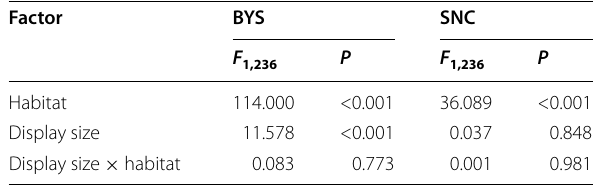
Table 2 Results of the linear mixed model test of the effects of habitat (forested vs. open patch) and display size on pollinator visitation rate per flower per hour in the two populations of H . ventricosa